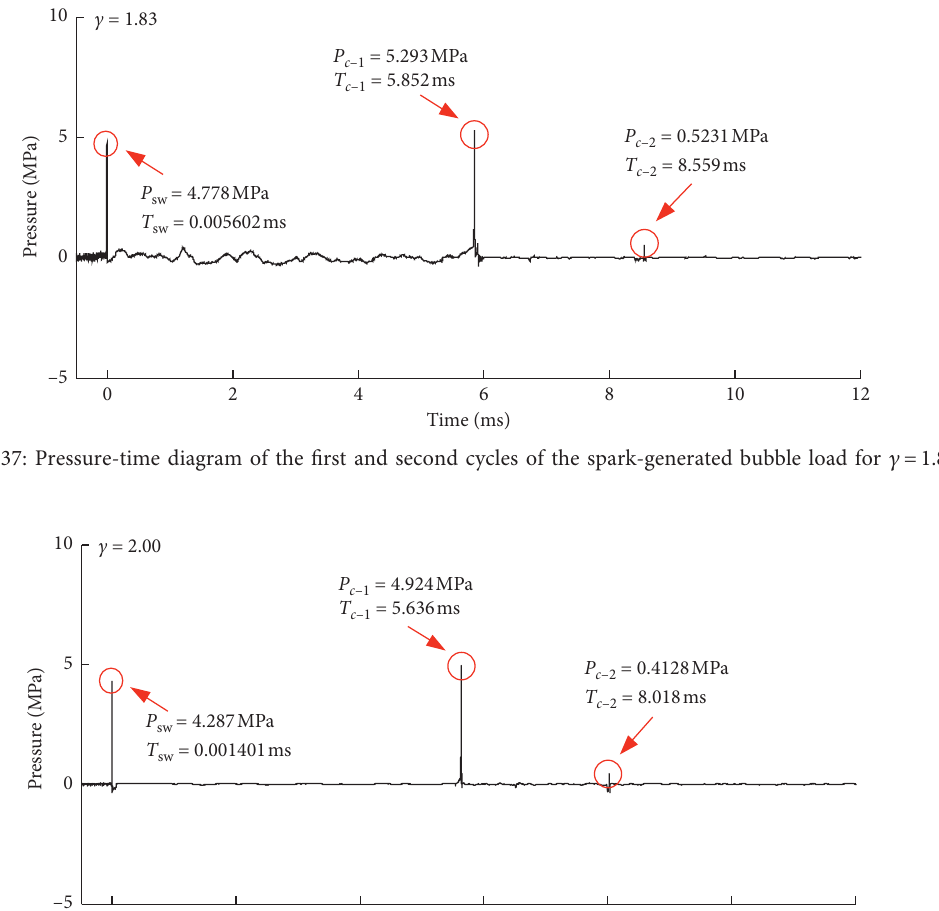
in the second cycle be less than the distance of first cycle. The shorter measurement distance will make the wall pressure load value measured by Hopkinson bar larger. Therefore, when 0.17 ≤ c ≤ 0.83, the load produced by